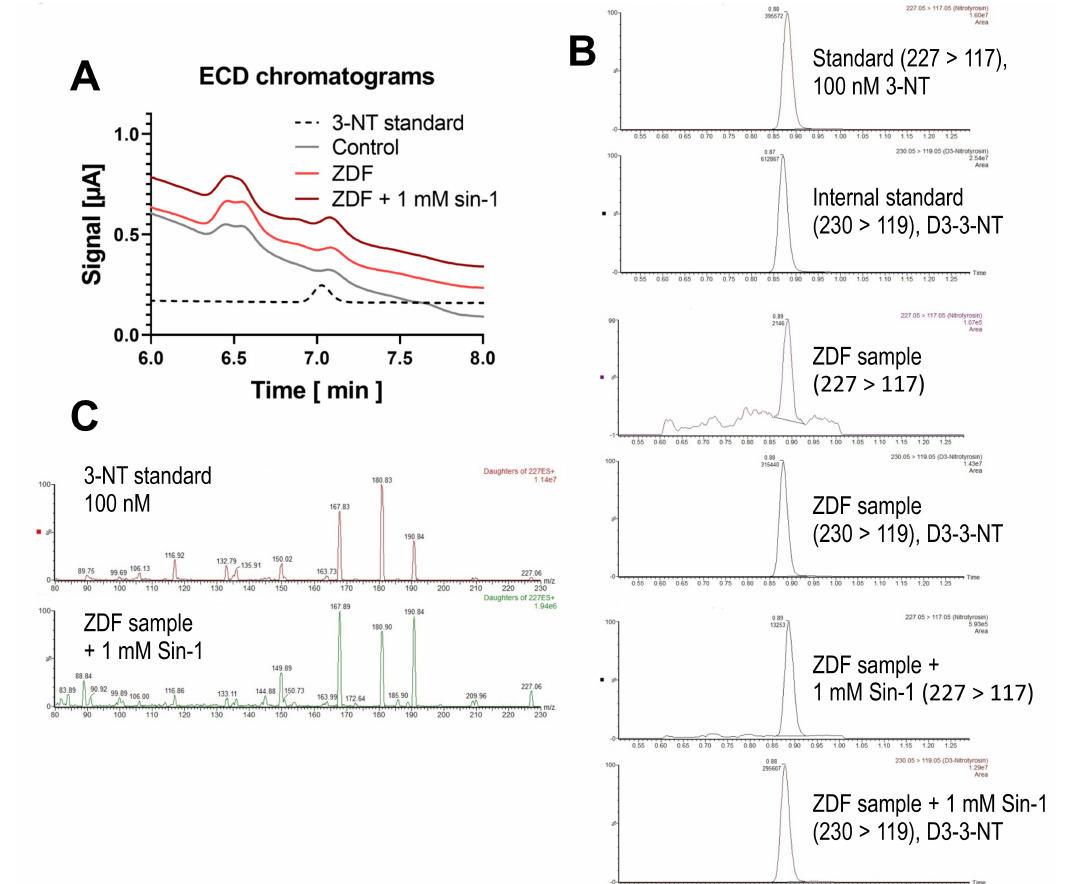
Figure 6. Detection of free 3-NT from control and diabetic animals with and without combined nitration by Sin-1. Kidney homogenates of healthy control and diabetic (ZDF) rats (10 mg / mL protein) were subjected to pronase digest before HPLC / ECD analysis or LC-MS / MS analysis. A special digestion protocol was used (see Methods for kidney samples). HPLC / ECD analysis was performed with 40 µ L of sample at 27 ◦ C with isocratic elution (0.75 mL / min, mobile phase: 26.3 mM sodium citrate and 10.9 mM sodium at pH 3.75; 3-NT eluted at 7.03 min). Representative chromatograms are shown for the HPLC / ECD quantification ( A ) or LC-MS / MS analysis ( B ). LC-MS / MS analysis was performed after adding an identical amount of deuterated 3-NT (D3-3-NT) to compensate for matrix e ff ects. Mass transitions monitored at 227 → 117 (3-NT) and 230 → 119 (D3-NT) are shown. Representative MS / MS spectra of precursor ion at m / z = 227 are shown for the 3-NT standard (100 nM) and the sample from ZDF rat with 1 mM Sin-1 treatment ( C